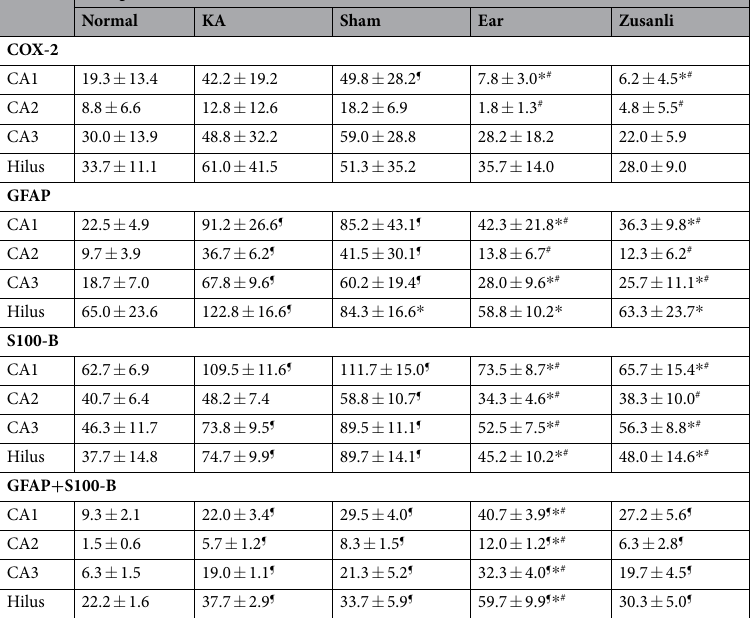
COX-2 immunoreactive cells in the CA1 region were higher in the sham group than in the normal, auricular, and Zusanli groups, and these counts were decreased through the 6-week application of ear ES and EA at ST36– ST37. These findings suggest that COX-2 levels were increased mainly in the CA1 region of the hippocampus, but the Western blot analysis did not discriminate among the CA1, CA2, CA3, and hilus regions. Our results were consistent with the finding that dendritic excitability originates from the CA1 region of the hippocampus in KA-treated rats 22 . CA1 plays an essential role in maintaining the balance between excitation and inhibition during epileptic seizures because perisomatic inhibitory input is provided when survival pyramidal cells are preserved in the CA1 region in patients with epilepsy 23 . In patients with temporal epilepsy and pilocarpine-treated epileptic rats, axon collateral increases in the pyramidial cells, and this increase can extend to the stratum pyramidale and stratum radiatum within the CA1 region. This reorganization of hippocampal CA1 plays a critical role in epileptogenesis 24 . COX-2 is an inflammatory mediator that produces an early inflammatory response to damage and plays a critical role in postseizure inflammation and neuronal hyperexcitablity 4 . A therapeutic strategy for drug-resistant